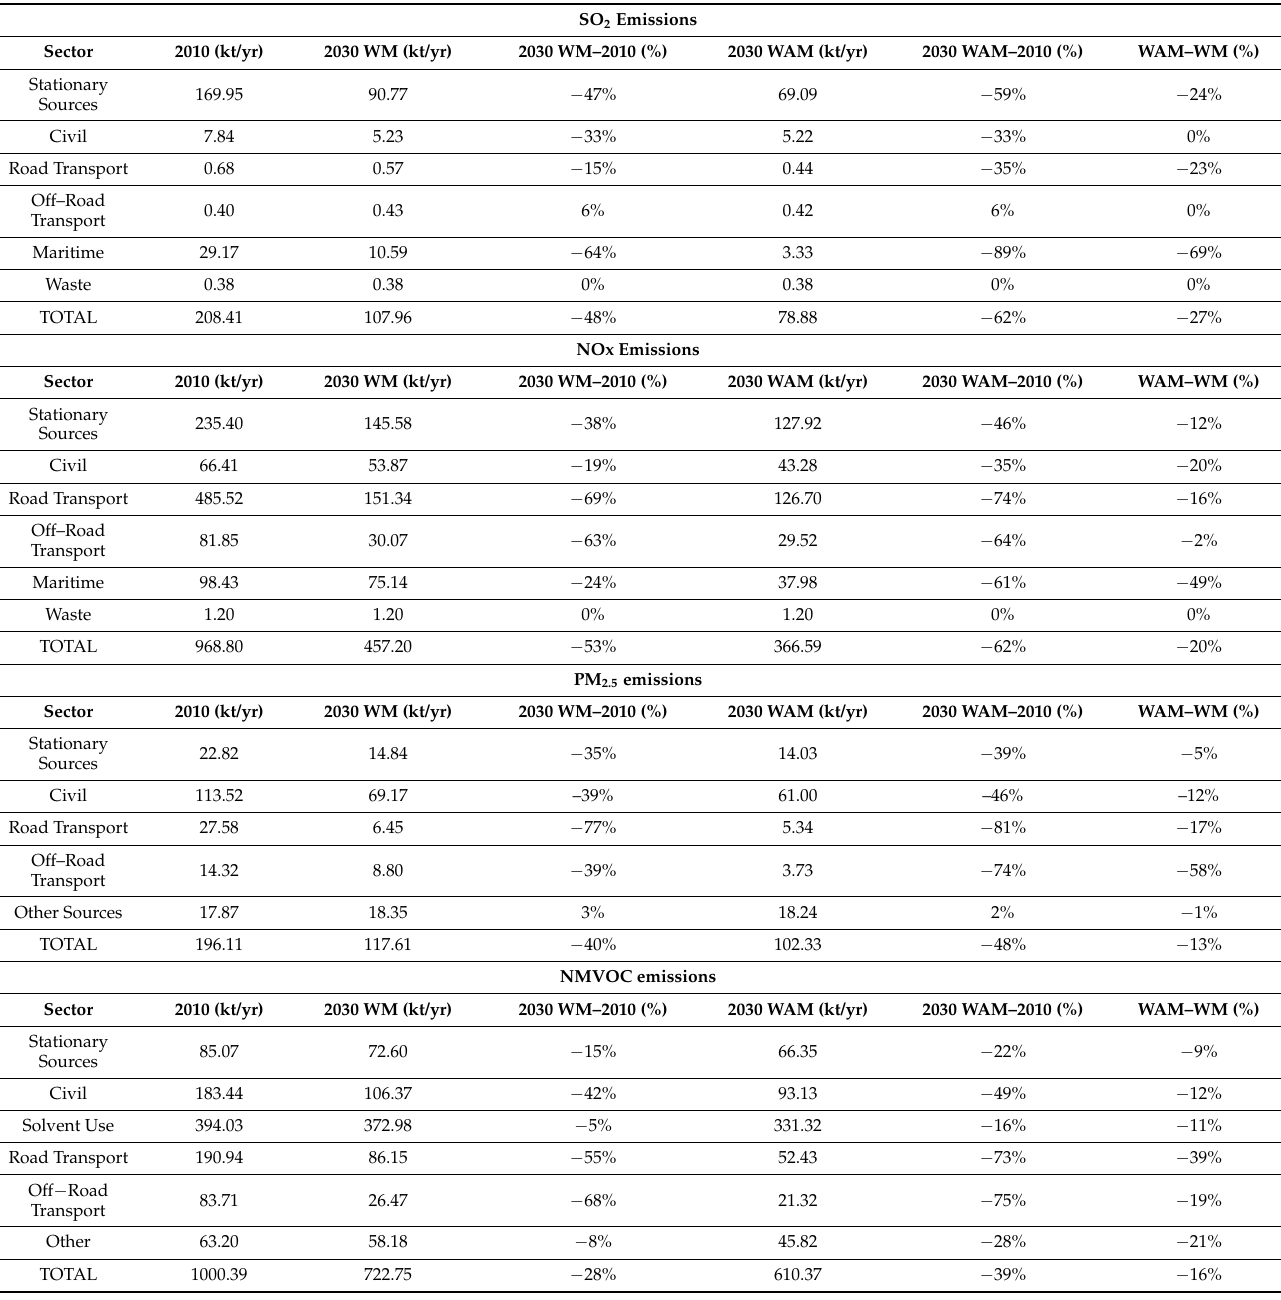
Table 6. National emissions by sector for the year 2010, the 2030 “With Measures” (WM) and WAM scenarios and their comparison. SO 2